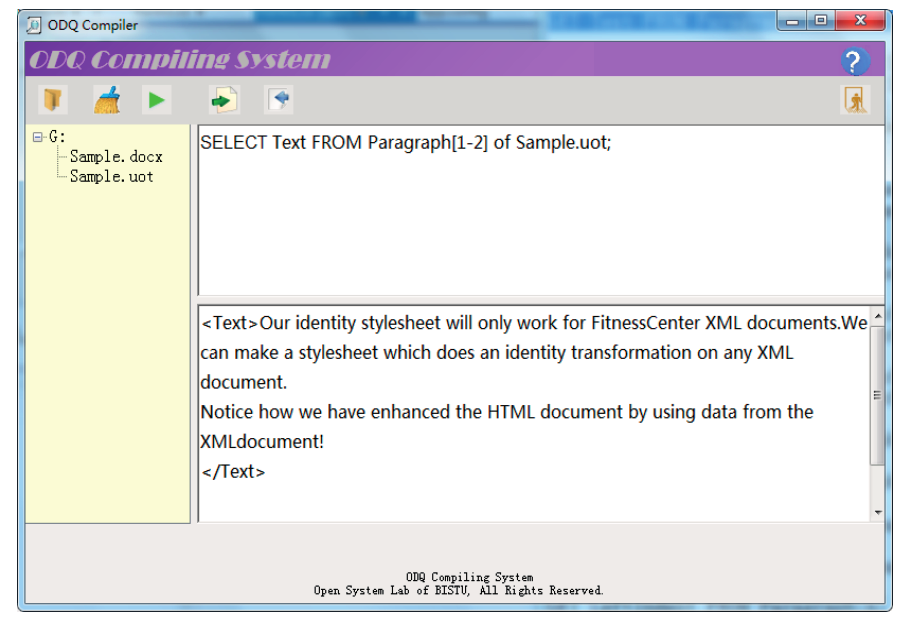
Figure 5. Fetch text content from the first two paragraphs from an UOF document.